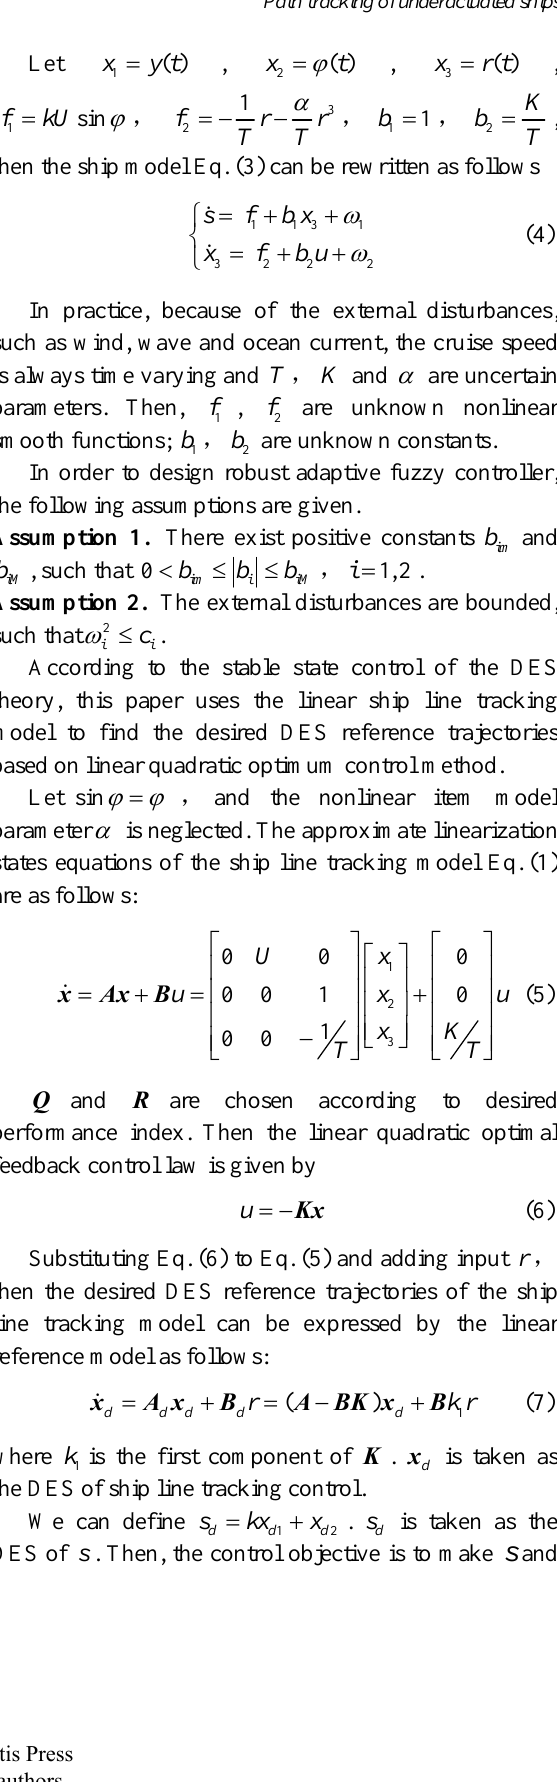
Fig. 2. is the straight-line trajectory keeping control model for the underactuated ships.